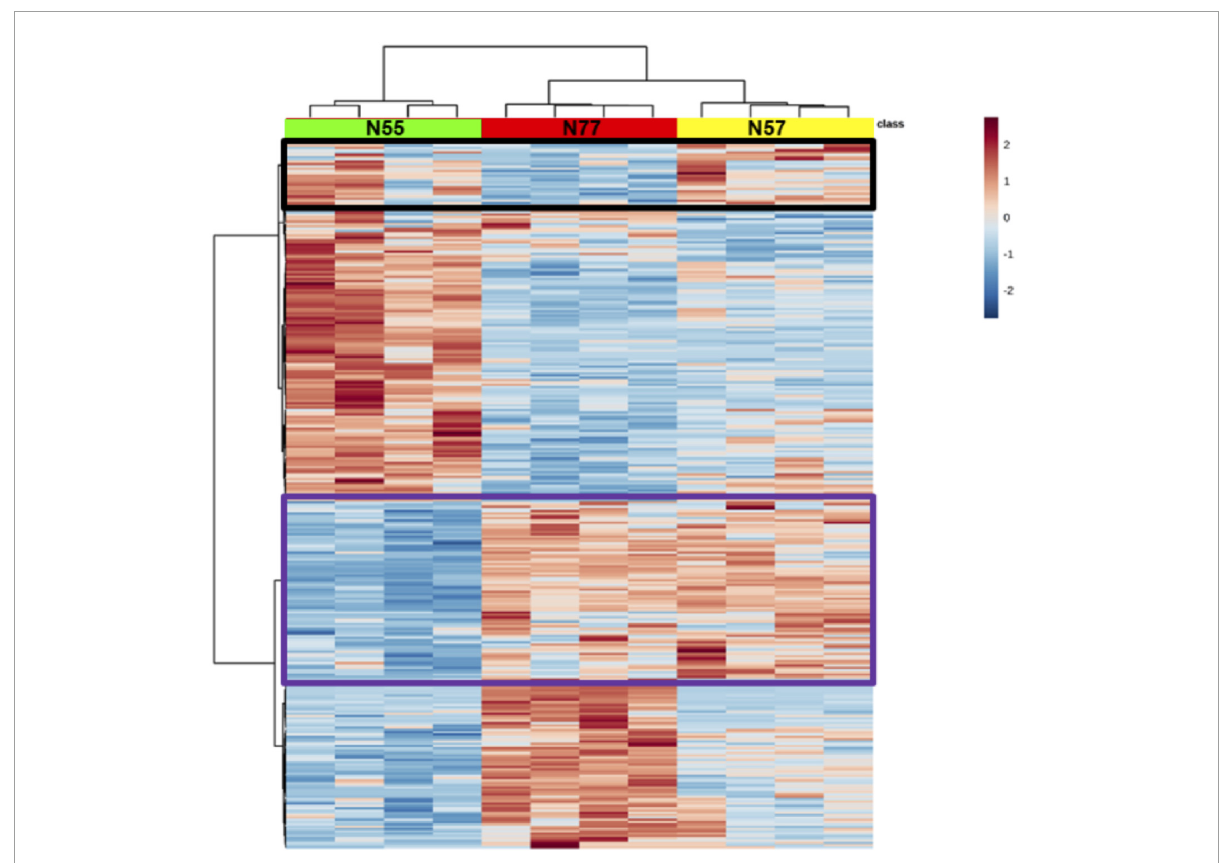
FIGURE3 Hierarchical clustering of differentially abundant proteins. In green, red and yellow are identified the columns for the replicates of each experimental condition, respectively N55, N77, and N57. In the heatmap, red and blue correspond to higher and lower abundant proteins, respectively. The tree in the x axis represents the similarity among experimental conditions regarding abundance of proteins and in the y axis the proteome similarities. Proteins having increased levels in common between conditions N55 and N57 and conditions N57 and N77 are evidenced in black and purple rectangles,